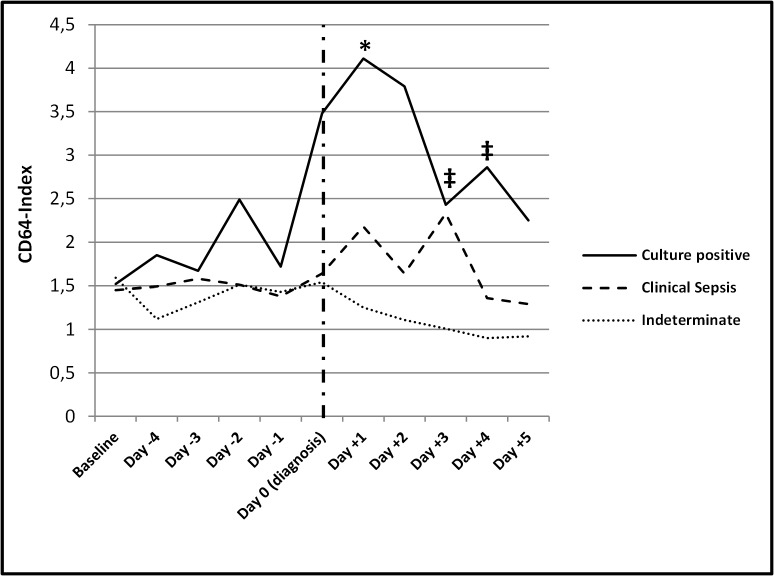
Median CD64 index values during the observation period.Median CD64 index was compared for every day during the observation period (day -4 until day +5) in the respective groups using the Mann-Whitney test. Median CD64 index was significantly higher on day +1 in the culture positive group compared to the clinical sepsis group (p <0.05; *) and significantly higher in the culture positive group compared to the indeterminate group on day +3 and day +4 (p <0.05; ‡). There was no difference in median CD64 index values between the clinical sepsis group and the indeterminate group. The dashed vertical line indicates the day of diagnosis (day 0). The numbers of samples for each data point are reported in Table 3.